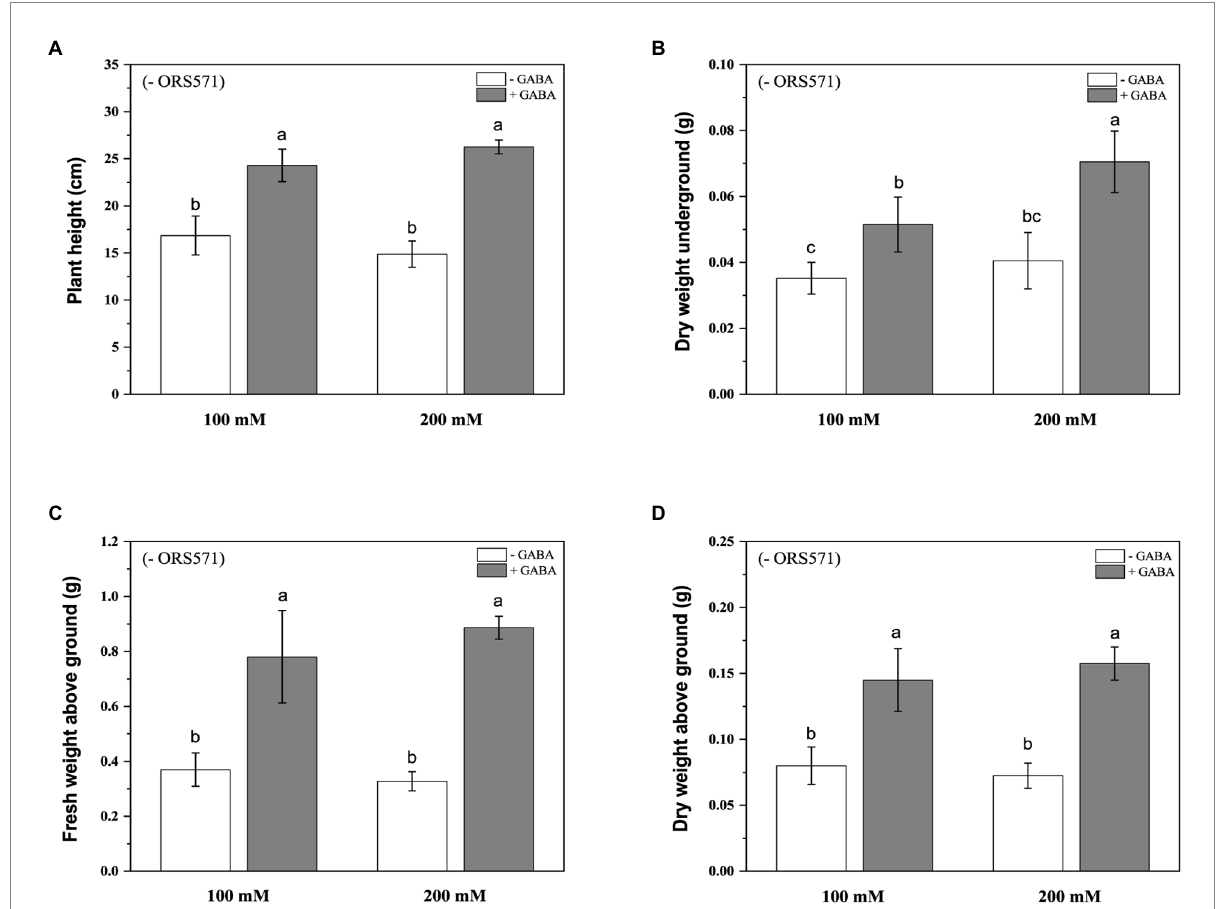
FIGURE 4 Effects of exogenous addition of GABA on the biomass aboveground/underground and plant height of Sesbania rostrata under different salt concentrations. The plant height (A) , DW underground (B) , FW above ground (C) , and DW above ground (D) were measured. Different lower-case letters in each column shape indicate a significant difference at p < 0.05 by statistical analysis. Error bars indicate standard deviations from four parallel